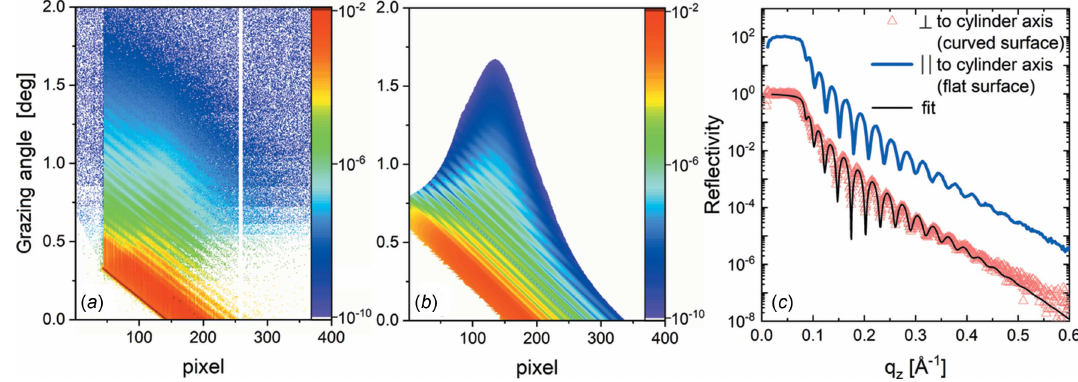
Figure 6 XRR results for solid cylindrical surfaces. Measured ( a ) and simulated ( b ) 2D scattering pattern of thin gold film on the cylinder with radius R = 516 mm (Sample 2). ( c ) XRR curves measured along the cylinder axis (blue line), reconstructed from reflection on the cylinder axis oriented perpendicular to the incident beam (red dots) and corresponding calculation with the slab model (black line). The blue curve is shifted by two orders of magnitude for